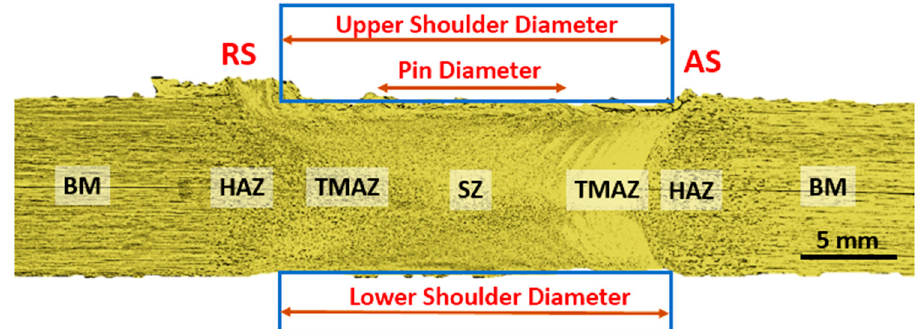
Figure 16. Macrograph analysis of BT-FSW of lap joints welded at 600 rpm and 200 mm/min.